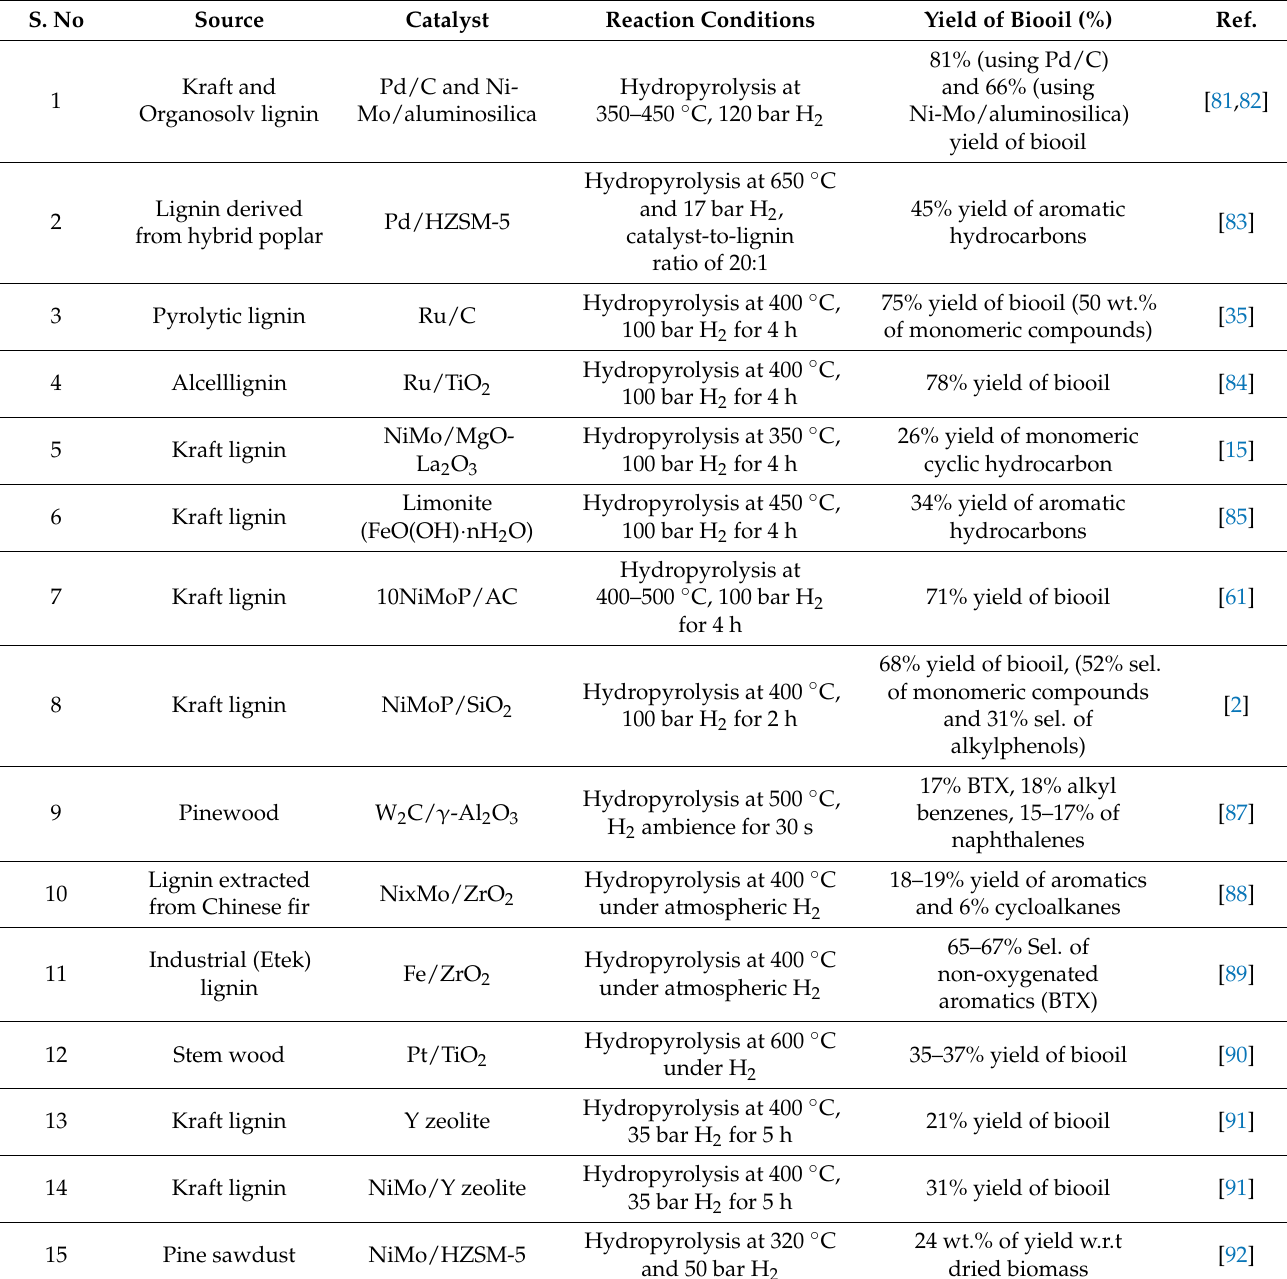
Table 2. Supported metal-catalyzed hydropyrolysis of